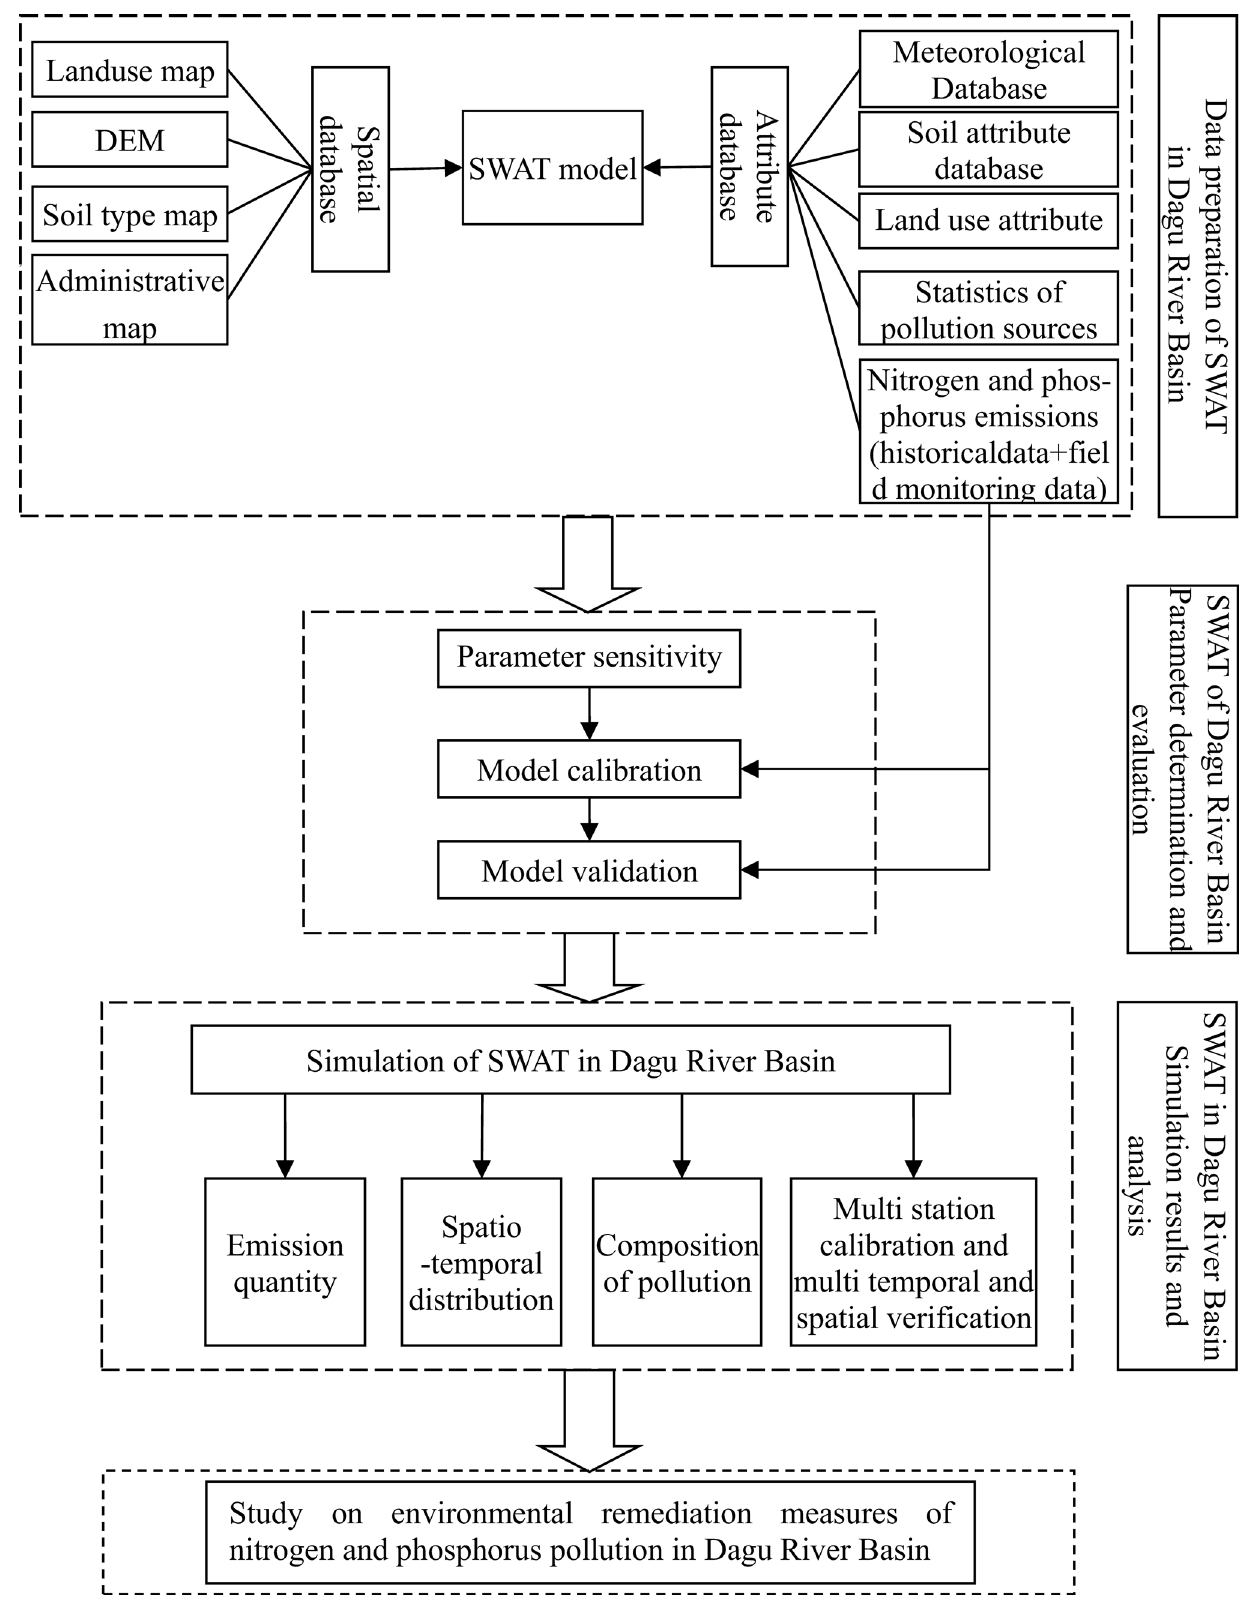
Fig. 2 Flow chart for SWAT simulation in Dagu River